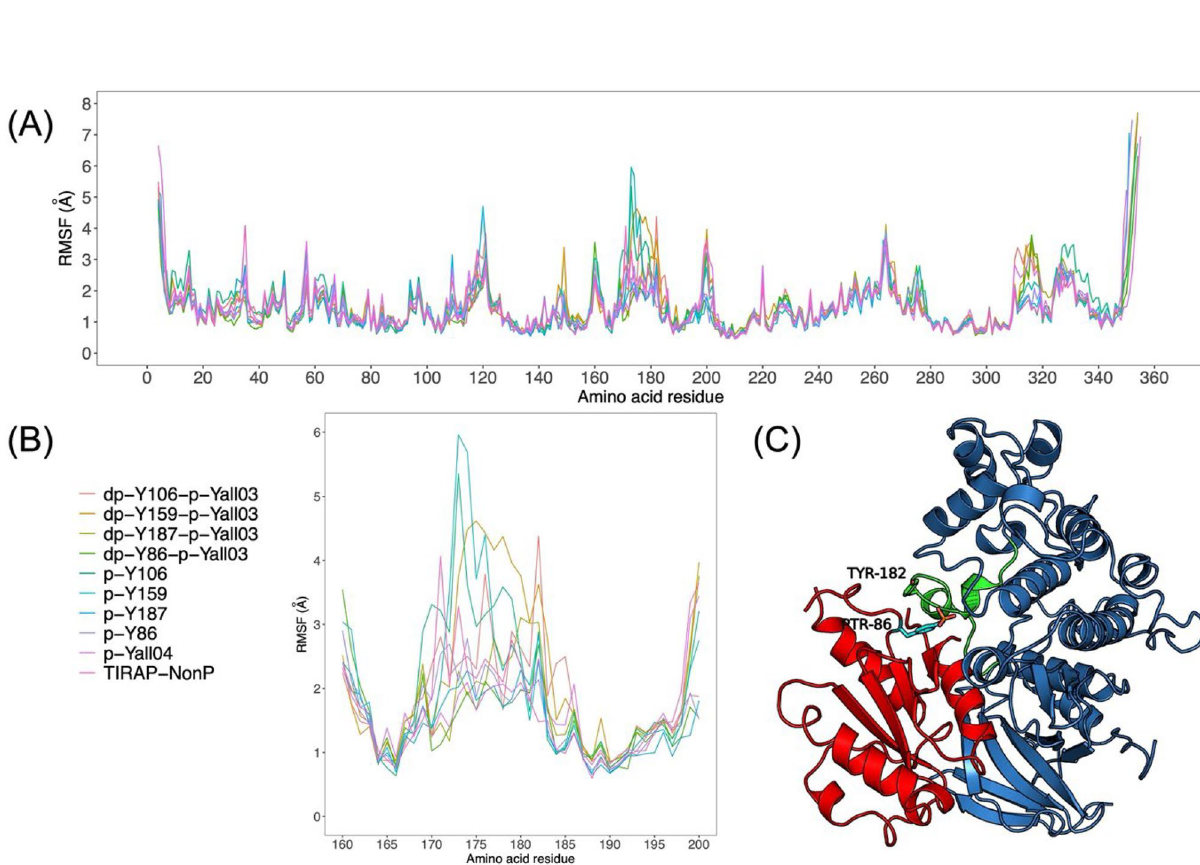
Figure 7. The root mean squared fluctuations (RMSF) of p38 MAPK in phosphorylated and non- phosphorylated TIRAP and p38 MAPK complexes. ( A ) RMSF of full p38 MAPK residues throughout the 500 ns MD trajectory. ( B ) RMSF of TIRAP interacting p38 MAPK residues throughout the 500 ns MD trajectory and ( C ) A cartoon diagram of TIRAP (red) and p38 MAPK (blue) complex prepared in PyMOL v2.3.4 tool showing the TIRAP interacting region (green) around the catalytic